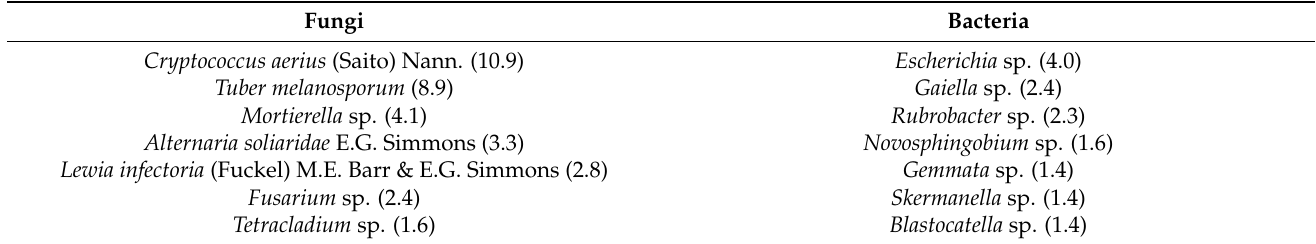
Table 2. The 10 most abundant bacterial and fungal species in the studied truffle orchards.